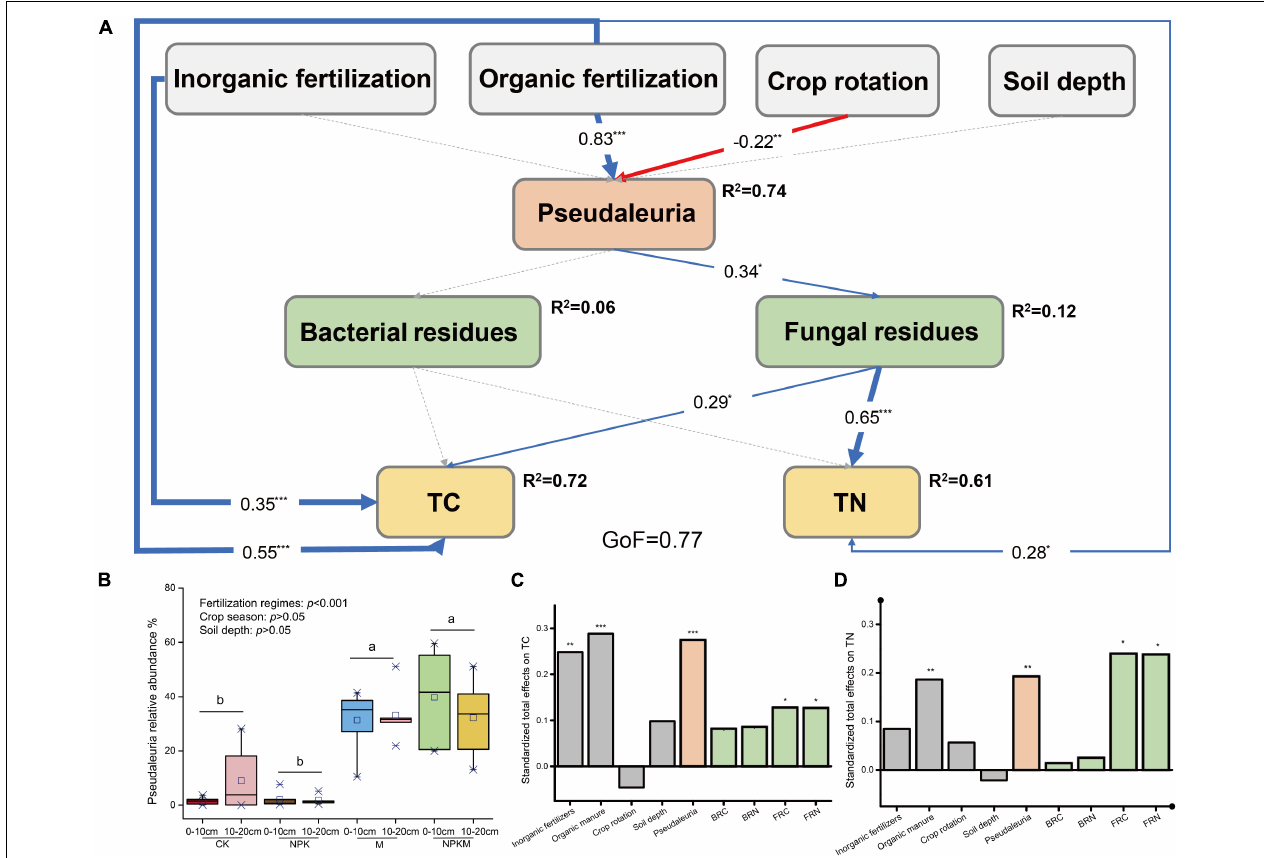
FIGURE 4 | The partial least squares path models illustrating the effects of fertilization regimes, crop rotation, and soil depth on soil C and N by influencing the distribution of Pseudaleuria and microbial residues (for more details, see Figure 2 ). (B) The relative abundance of Pseudaleuria in different treatments and its difference between fertilization regimes, crop season and soil depth were test by LSD t -test. The different letters indicate significant difference. The standardized total effects of parameters on SOC (C) and TN (D) . Asterisks indicate significant differences. * p < 0.05, ** p < 0.01, *** p <